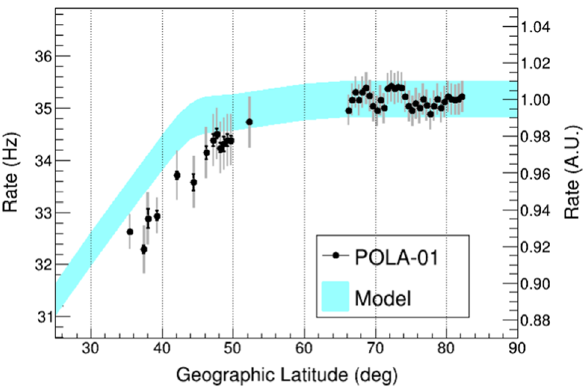
Fig. 10 Cosmic particle rate measured by the POLA-01 detector as a function of the geographic latitude compared with the expectations of the PARMA model (light blue